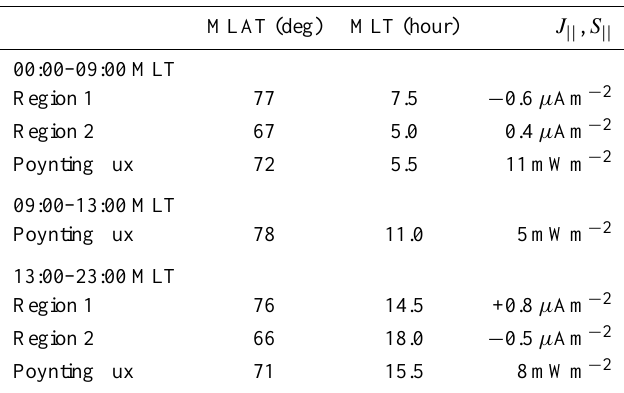
Table 2. Integral properties for the three regions of enhanced Poynt- ing flux for 16:00–17:00 UT, 11 March 2000. Integrated power den- sity extends down to a contour of 4mWm − 2 in Fig. 2c.